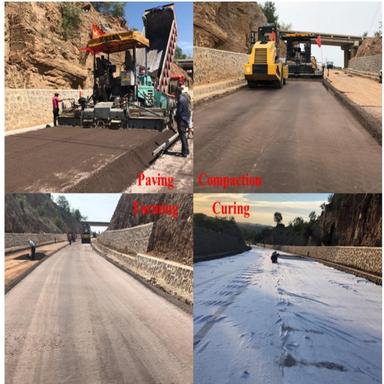
Field picture of the pilot test.